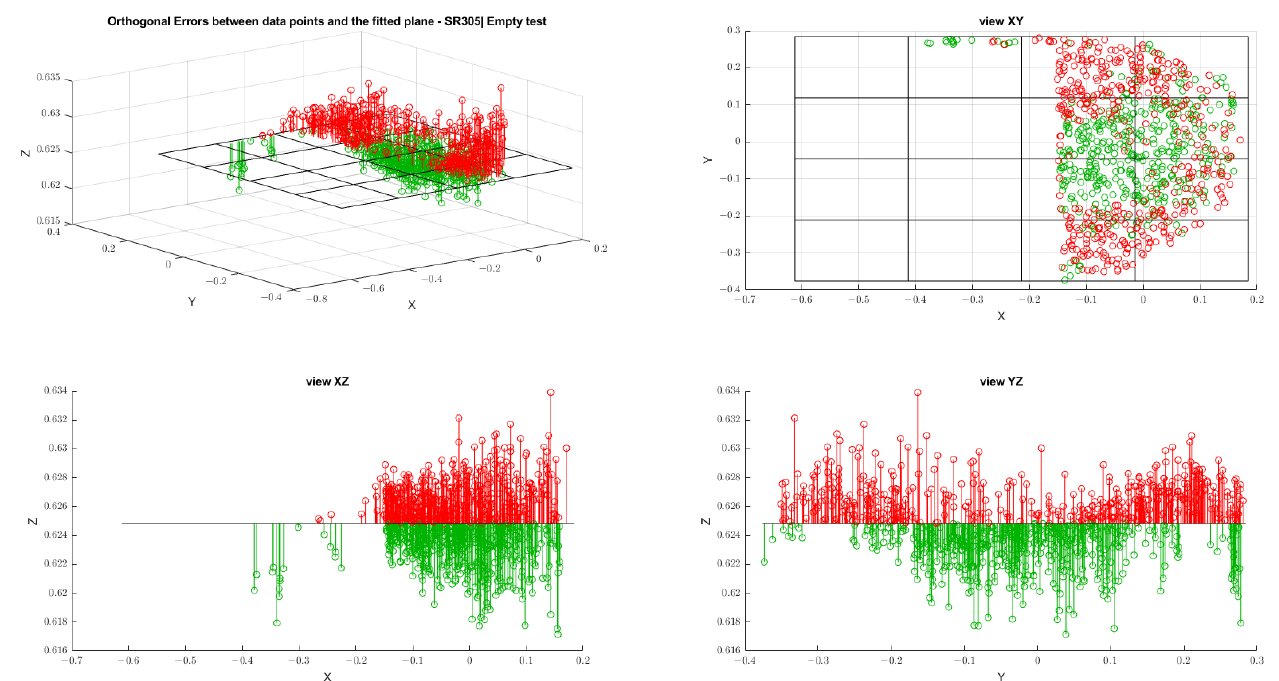
Figure A15. Results of orthogonal errors for the SR305 camera referring to the wall test.